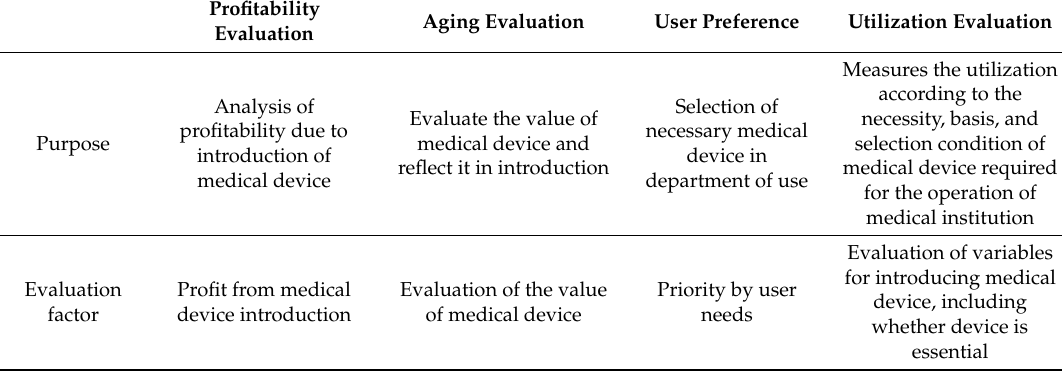
Table 2. Methods for comparing and evaluating multiple medical